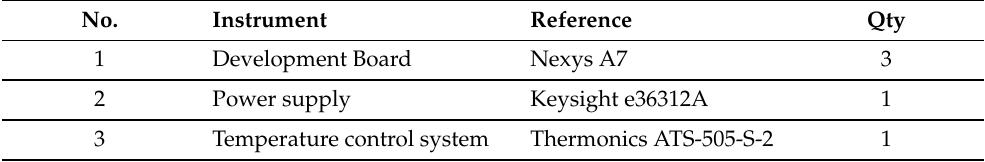
Table 5. Features of the test system for the temperature and voltage characterization